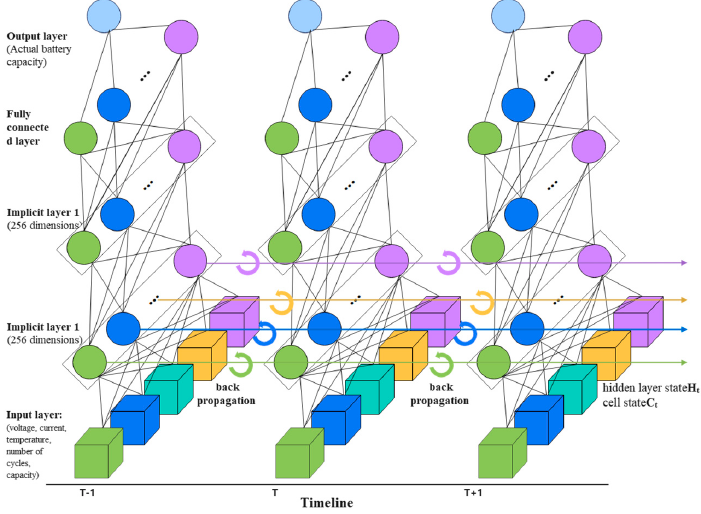
Figure 7. Network structure.